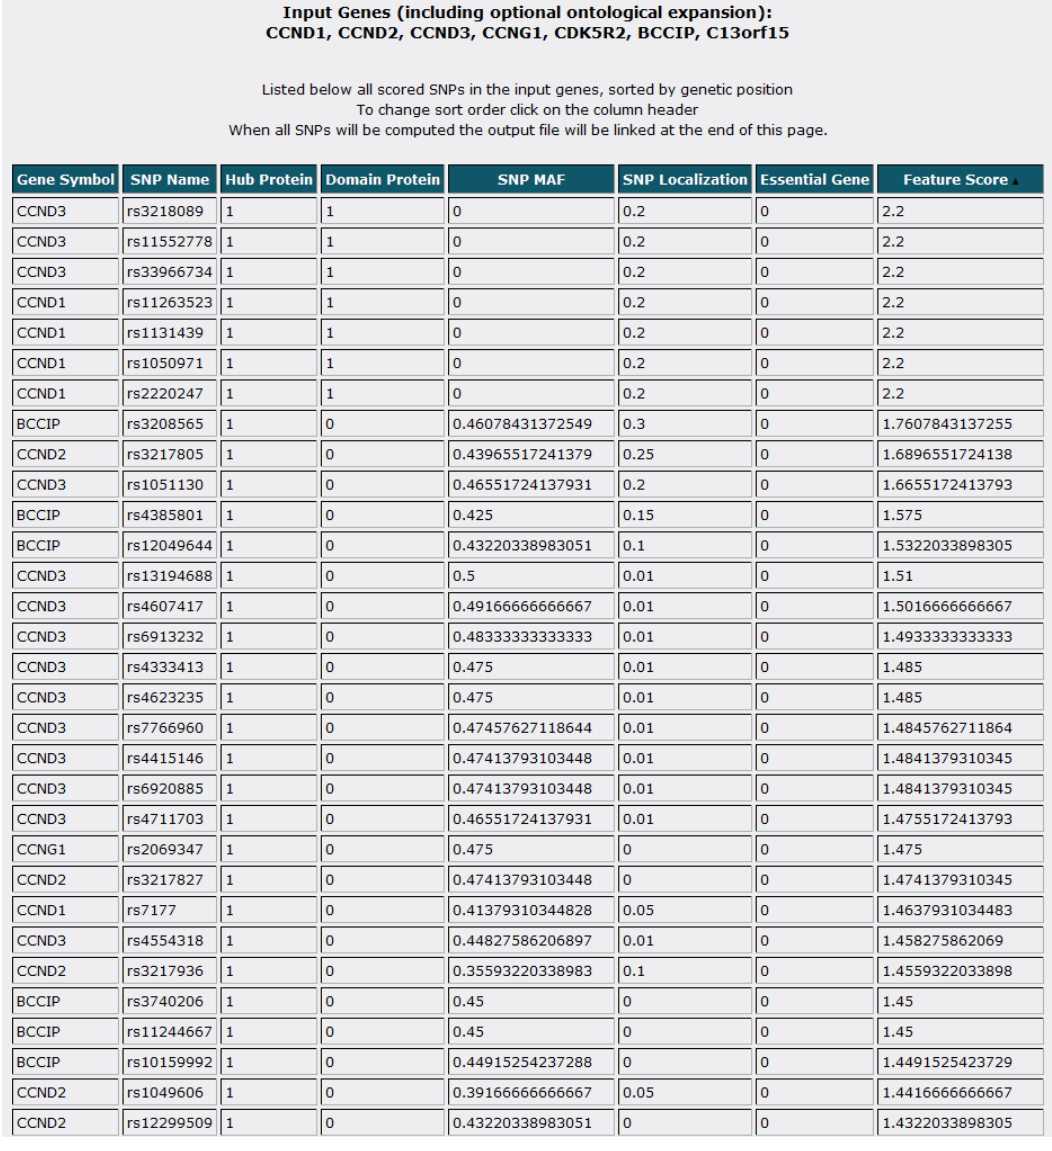
Figure 4: Screenshot from the web site. Results page showing SNPs ranked list obtained from CCND1 example, discussed in the text. SNPs are sorted by features score. Ontological expansion is performed with similarity threshold set to 0.7; chosen features weights are shown in Figure